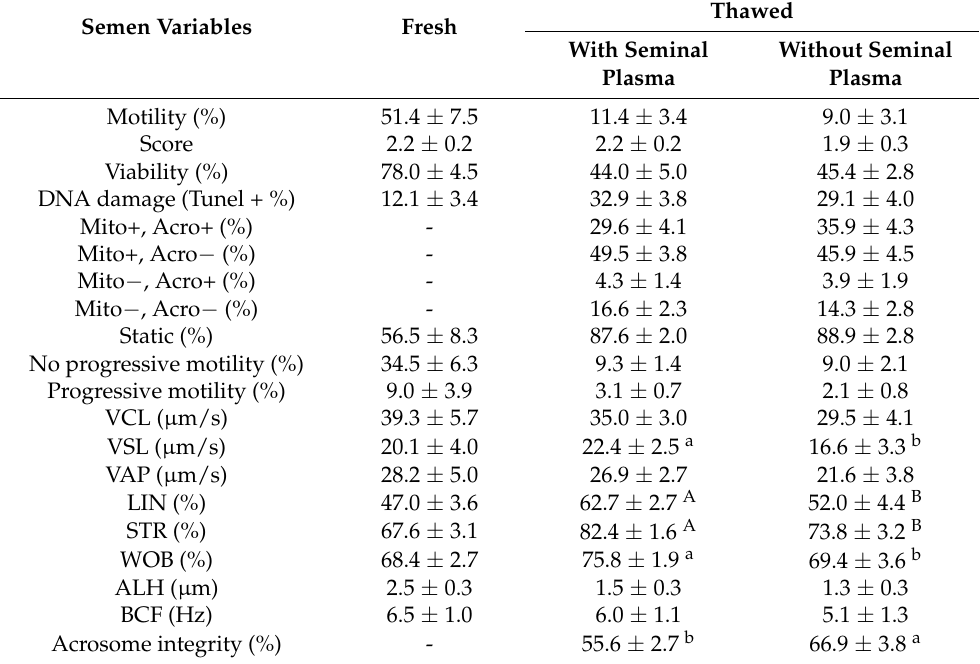
Table 2. American flamingo sperm variables in fresh and frozen–thawed samples with or without seminal